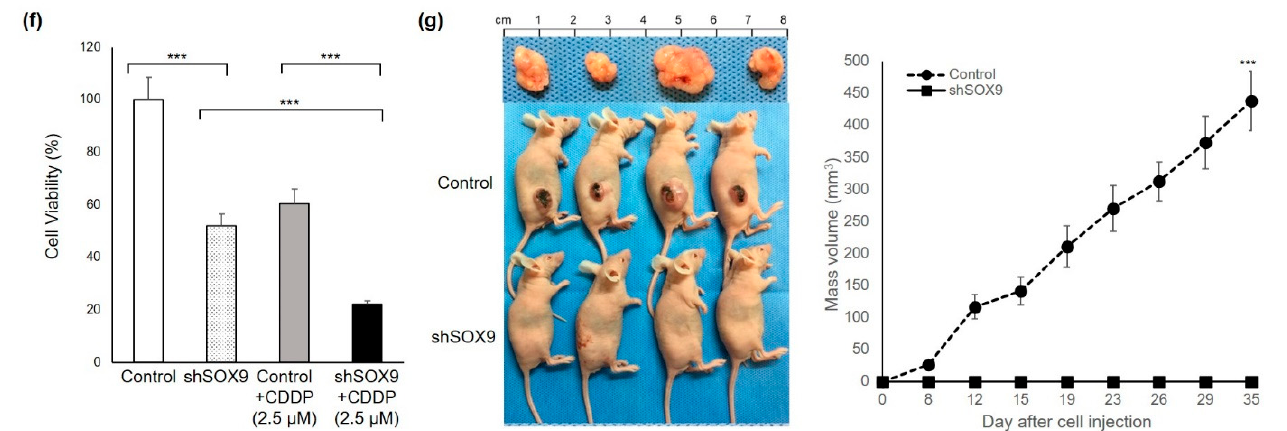
Figure 2. SOX9 silencing induces cancer cell death in vitro and in vivo. Knockdown of SOX9 in